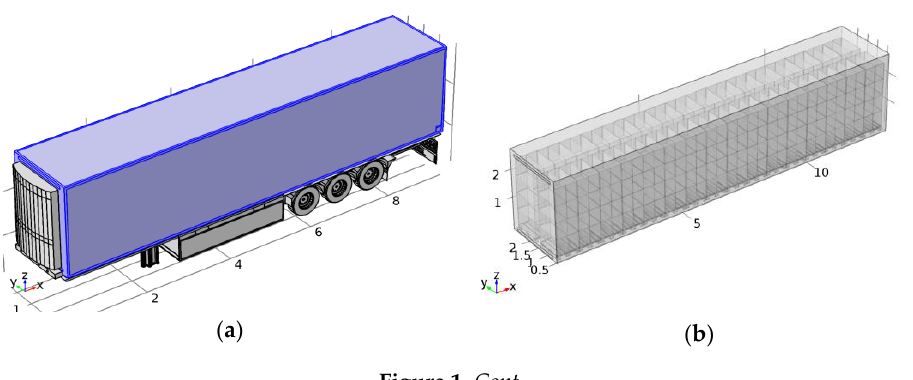
Table 1. Boundary conditions used for turbulence